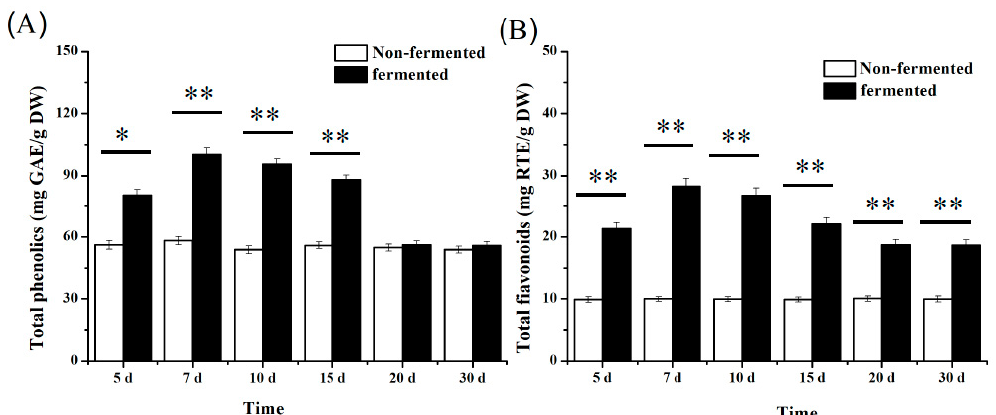
Figure 4. Contents of the total phenolic compounds (A) and flavonoids (B) in non-fermented and fermented HRLs by E. amstelodami BSX001. Note: ** extremely significant difference ( p < 0.01) and * significant difference ( p < 0.05).